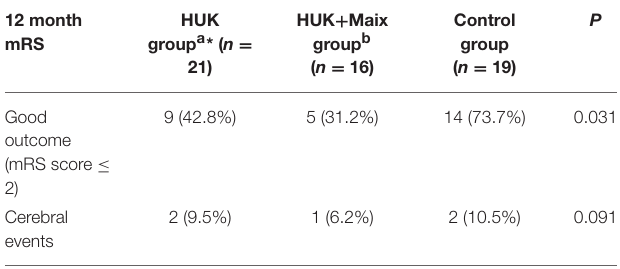
TABLE 2 | Comparison of NIHSS scores of three groups before and after treatment. Group